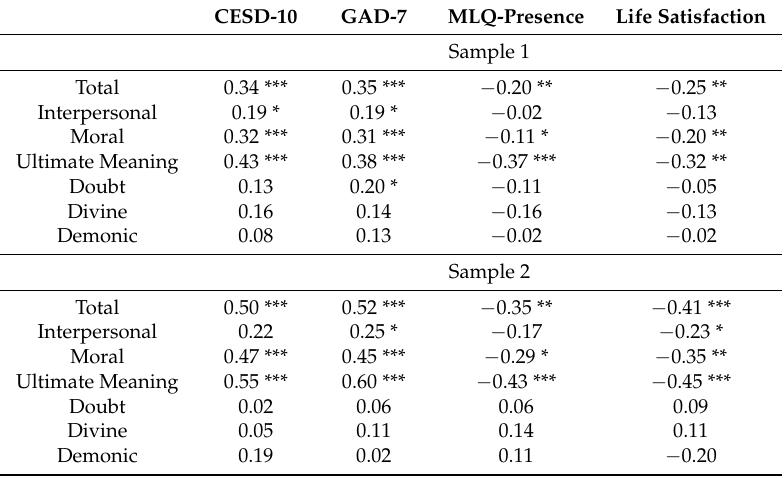
Table 4. Correlations between RSS Subscales and Variables of Interest among Atheist